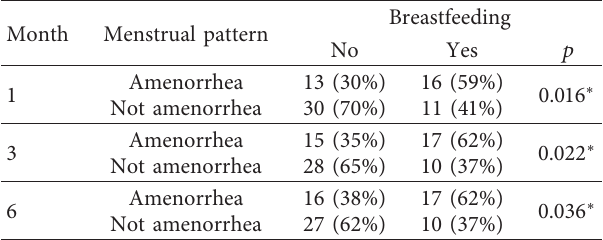
Table 9: The relationship between breastfeeding and amenorrhea in two-rod